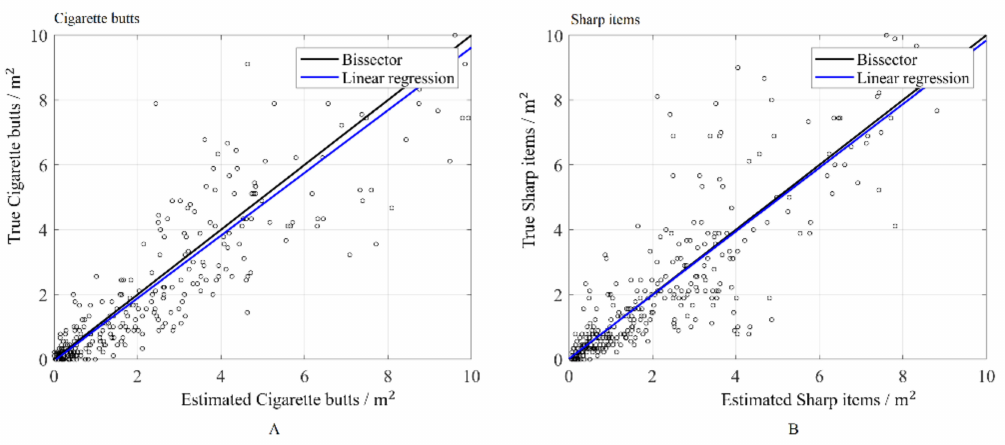
Figure 11. Split–sample validation of ( A ) cigarette butts ( B ) sharp items.